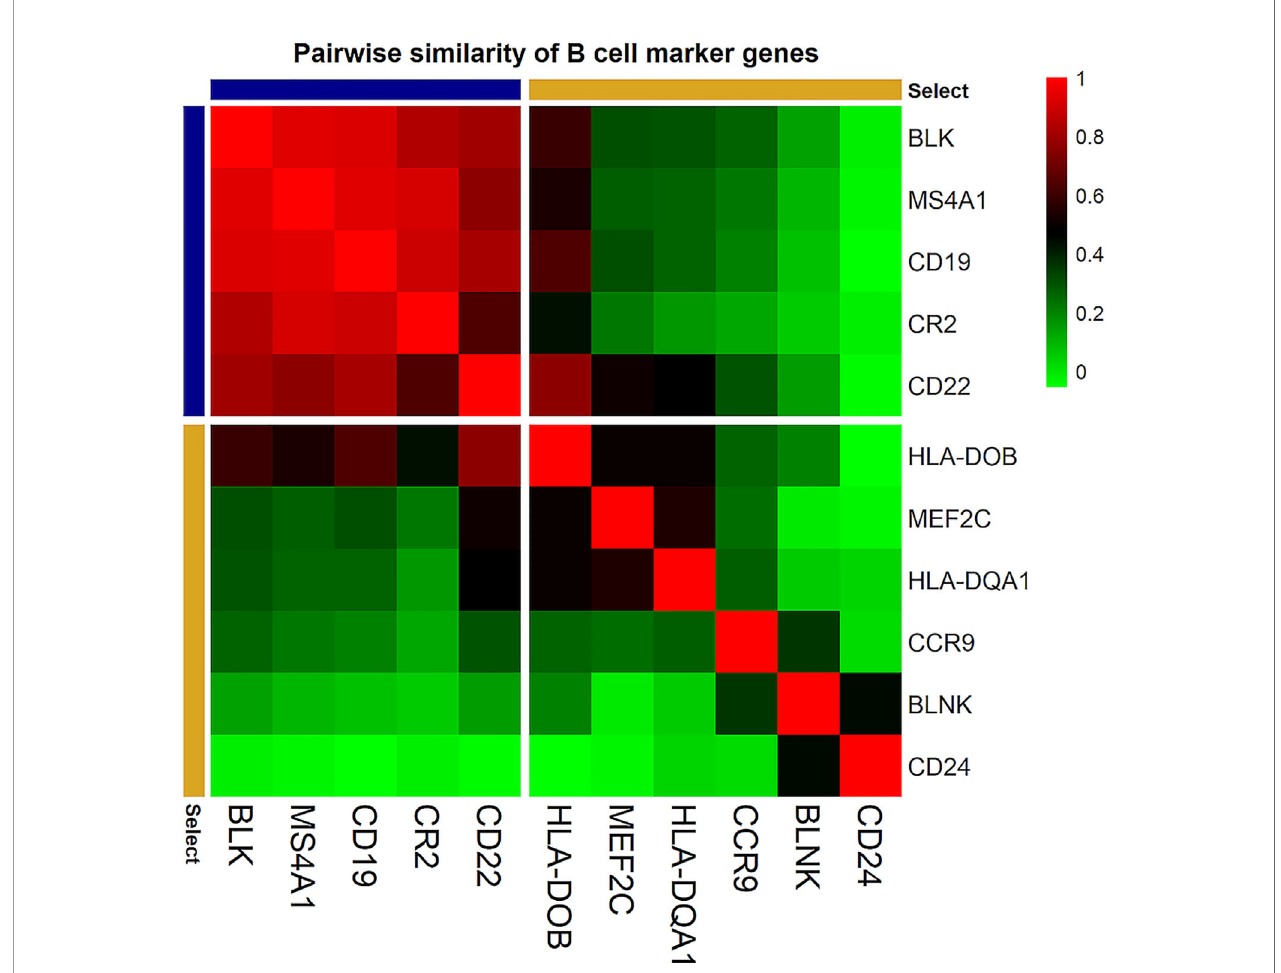
FIGURE 2 | Correlation plot of the pairwise similarity of candidate marker genes tested to identify B cells. The pairwise similarity varies between the 11 selected genes. Five genes (blue) showed a high pairwise similarity ( ≥ 0.6). These genes were selected to identify B cell in fi ltration in PDAC tissue samples. Six genes (yellow) showed a low pairwise similarity (< 0.6). these genes were not used to identify B cell in fi ltration in PDAC tissue samples. The red color in the correlation plot presented the highest correlation score between the genes (R 2 = 1); the green color presented the lowest correlation score (R 2 =